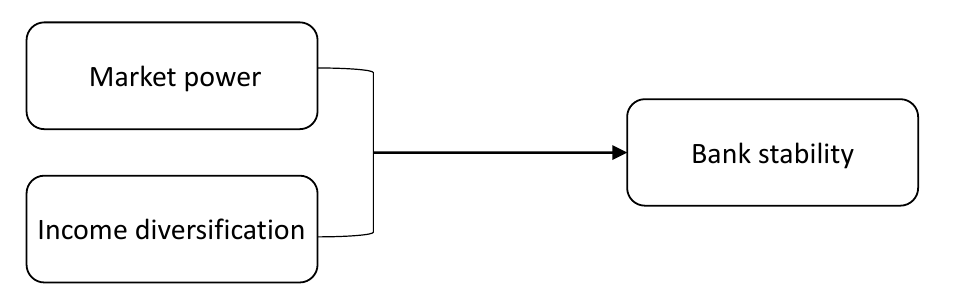
Figure 1. Conceptual